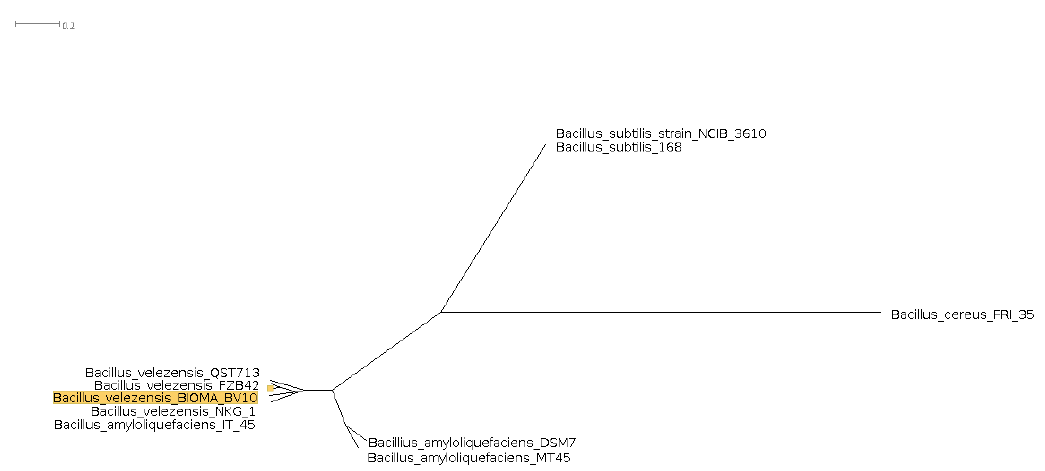
Figure 7. Phylogenomic tree representing the similarity between B. velezensis B.BV10 and strains from the B. subtilis group. The matrix was generated by Gegenees and exported to SplitsTree4 for making the tree using the UPGMA method. Table 3. Genomic comparisons of different Bacillus species using the OAT software for ANI% determination using OrthoANI and the Genome-to-Genome Distance Calculator (GGDC) to calculate dDDH and distance values between the genomes.